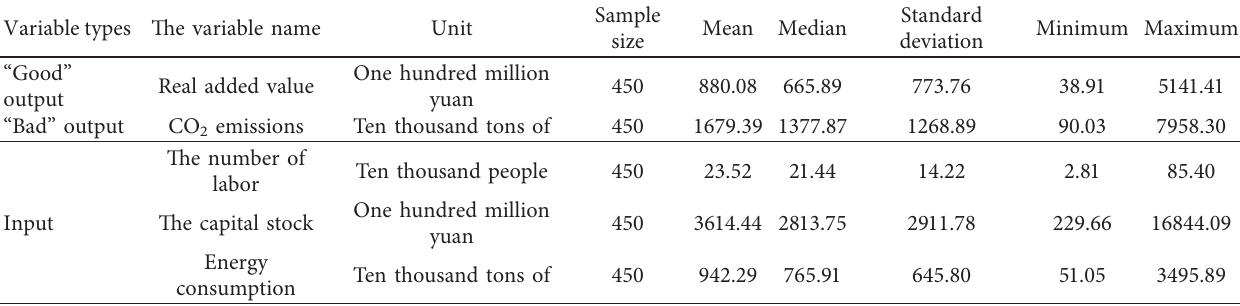
Table 2: Descriptive statistical results of input-output variables.